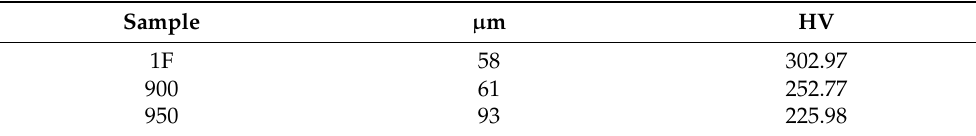
Table 2. Average values of the grain size by ASTM E-112-96 [11] ( µ m), and the Vickers hardness (HV)